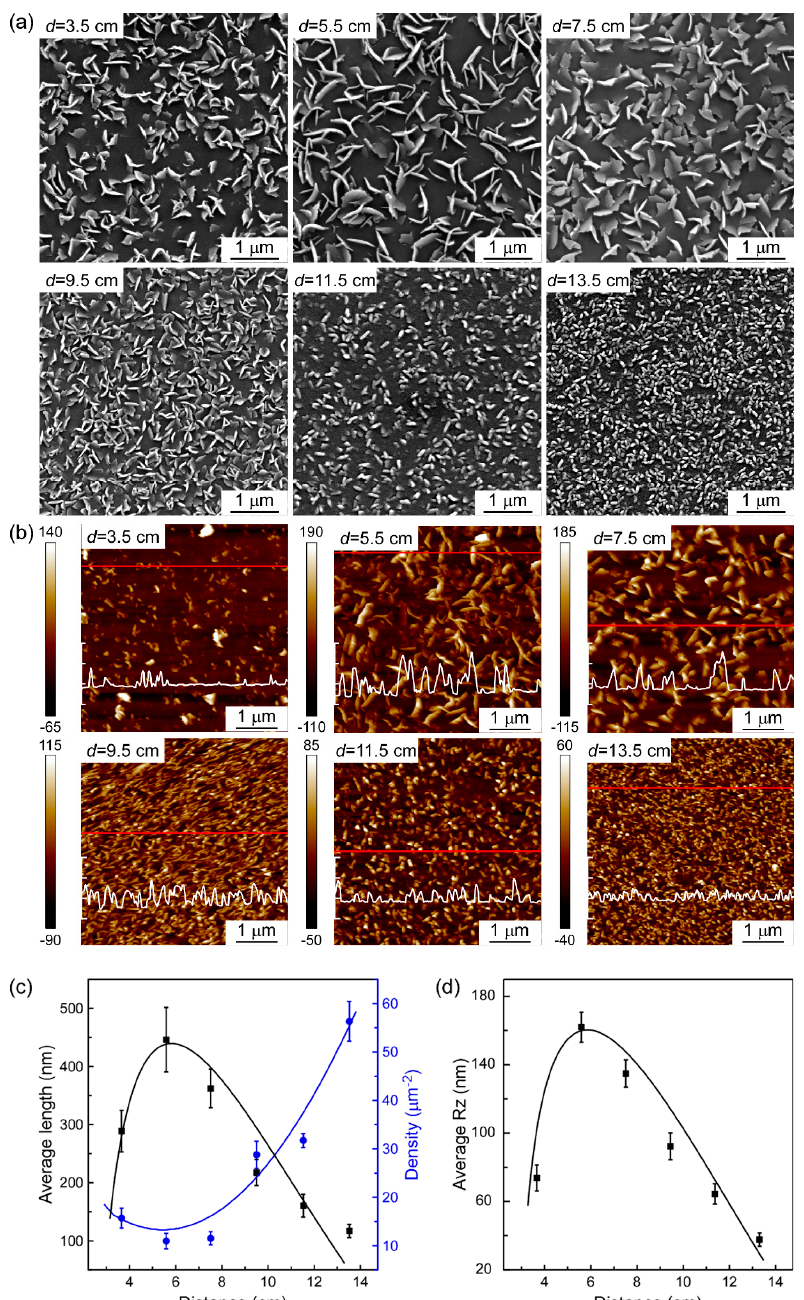
Figure 4. FESEM ( a ) and AFM ( b ) images of MoS 2 nanosheets deposited at different d values (3.5, 5.5, 7.5, 9.5, 11.5, 13.5 cm). The white lines overlapped on the AFM images represent the height profiles for the red lines, the scale bar is 100 nm for each interval; ( c ) Effect of d on the average length and area density (which are calculated from measured statistics of single sheet lengths and numbers by Nano measurer software) of the nanosheets. ( d ) Effect of d on average depth between peak and valley ( R z).